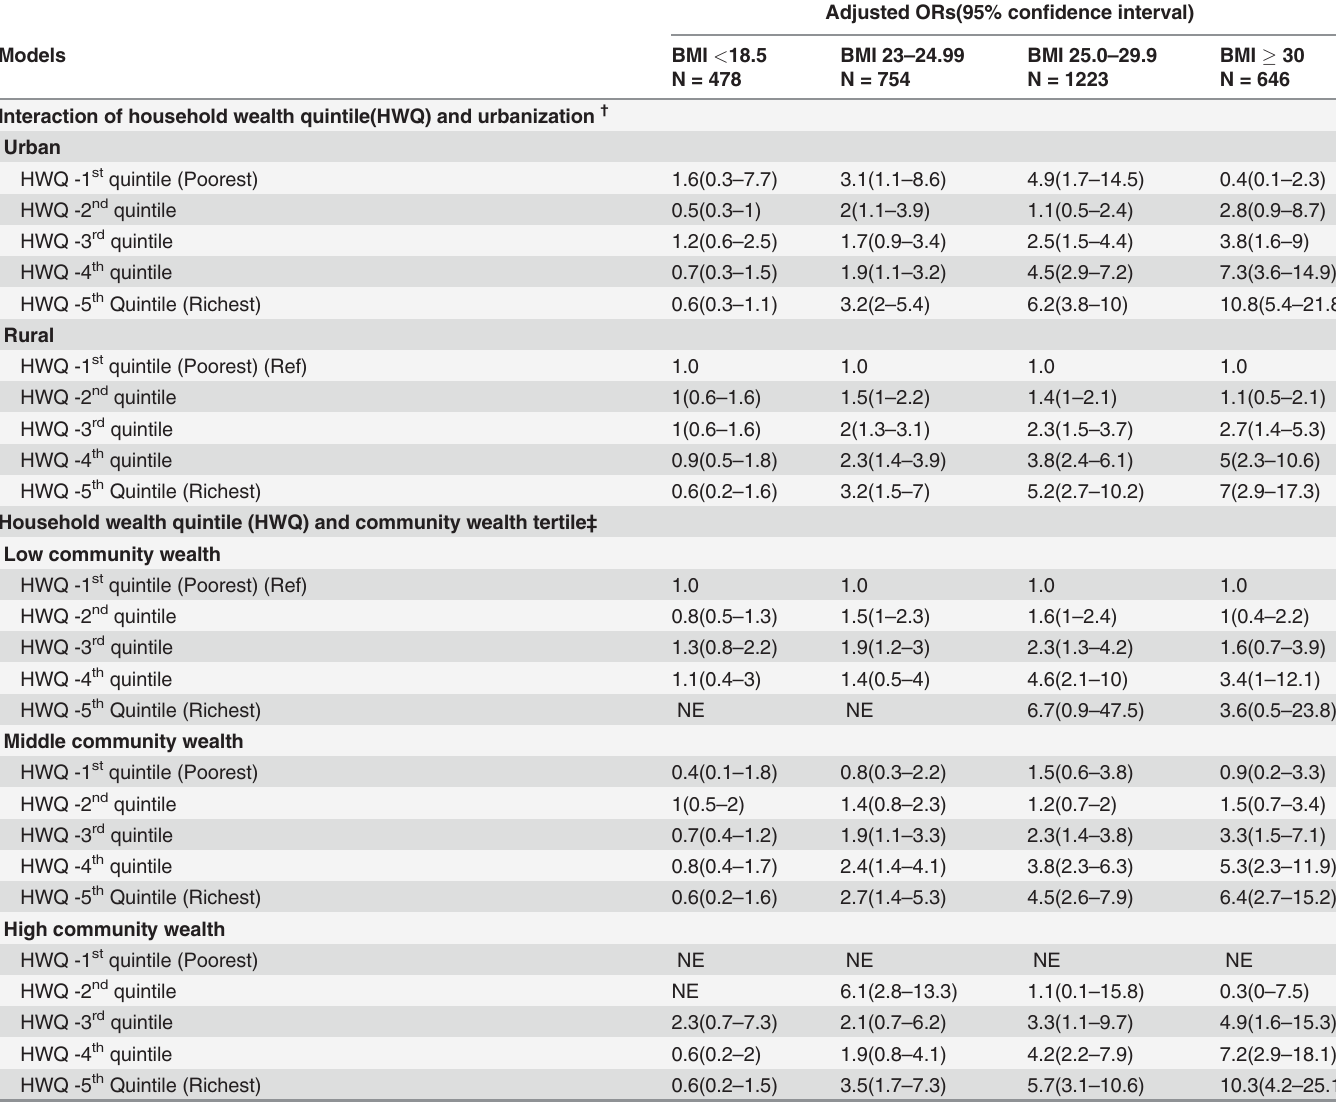
Table 3. Multivariable models presenting interaction between household socio-economic position and urbanicity, and interaction between house- hold and community socioeconomic position for association with categories of BMI among women, Demographic and Health Survey of Pakistan 2012 – 13 *